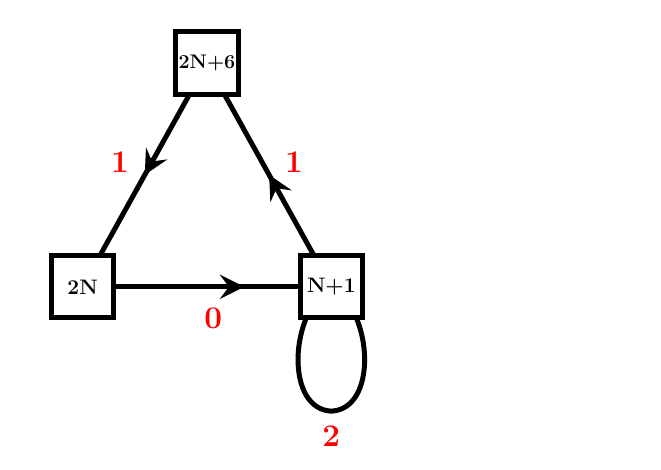
Figure 17: A tube theory with one USp ( 2 N ) puncture and one SU ( N + 1 ) punc- ture. The flux corresponding to this tube breaks the 6 d SO ( 4 N + 12 ) symmetry to U ( 1 ) × SU ( 2 N + 6 ) for general N (breaks E to U ( 1 ) × E for N = 1). The line 8 7 starting and ending on the same gauge node is in two index antisymmetric represen- tation. We have a superpotential terms corresponding to the triangle and coupling the two index antisymmetric to the antisymmetric square of the bifundamental be- tween USp ( 2 N ) and SU ( N + 1 ) . The R charges depicted here are the six dimensional